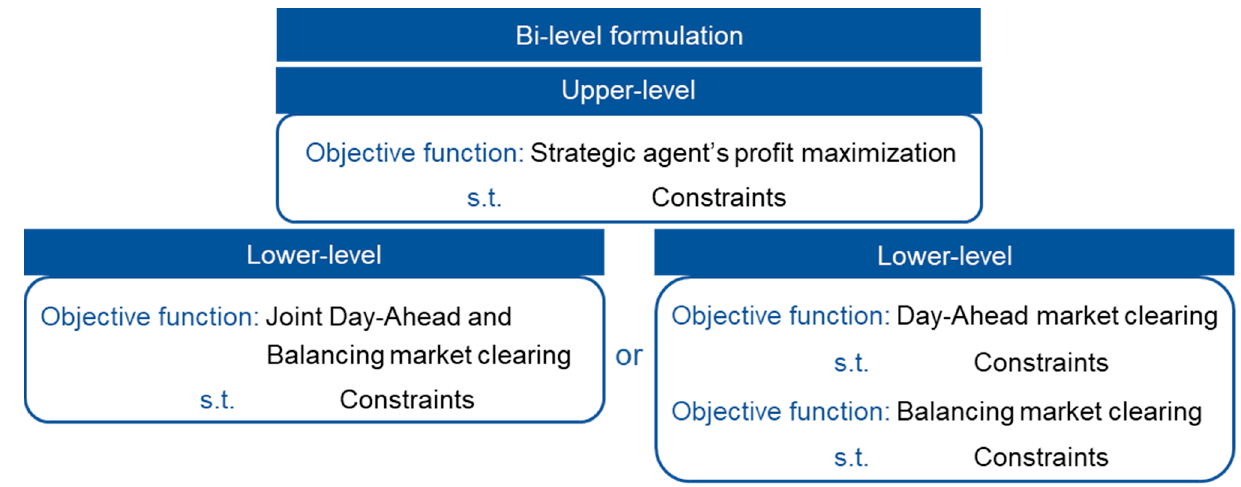
Figure 2. Bi-level framework of strategic agent’s behavior.